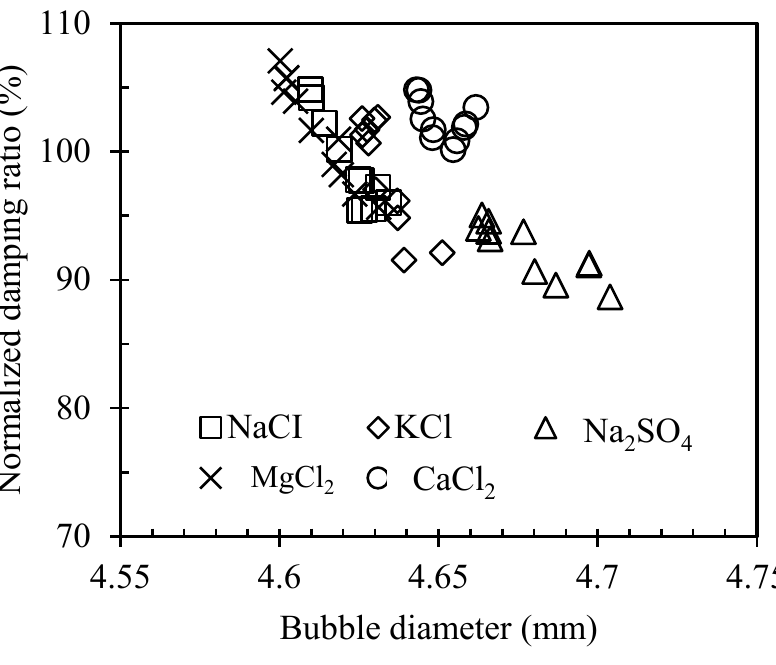
Figure 8. Normalized acoustic frequency as a function of the bubble size estimated by the Minnaert relationship.